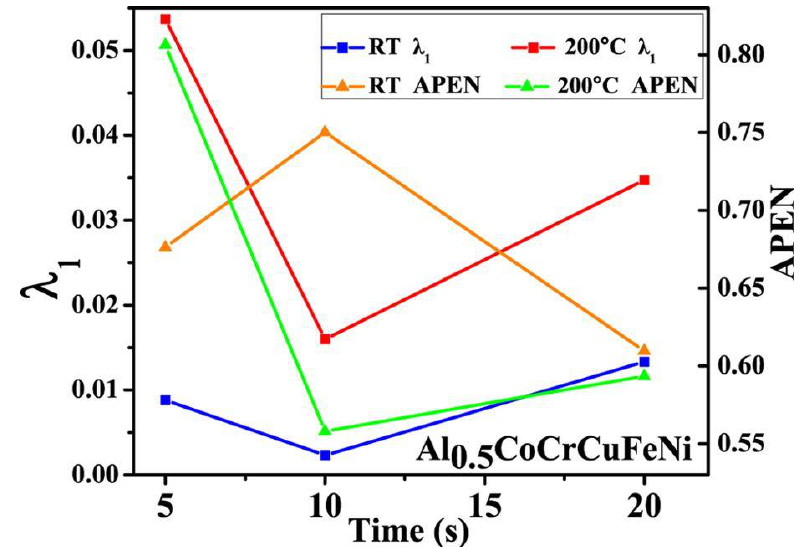
Figure 20. The largest Lyapunov exponent, λ 1 , and approximate entropy, ApEn, for the holding times ◦ C (reproduced from Reference of 5, 10, and 20 s at RT and 200 °C (reproduced from Reference [154]). of 5, 10, and 20 s at RT and 200